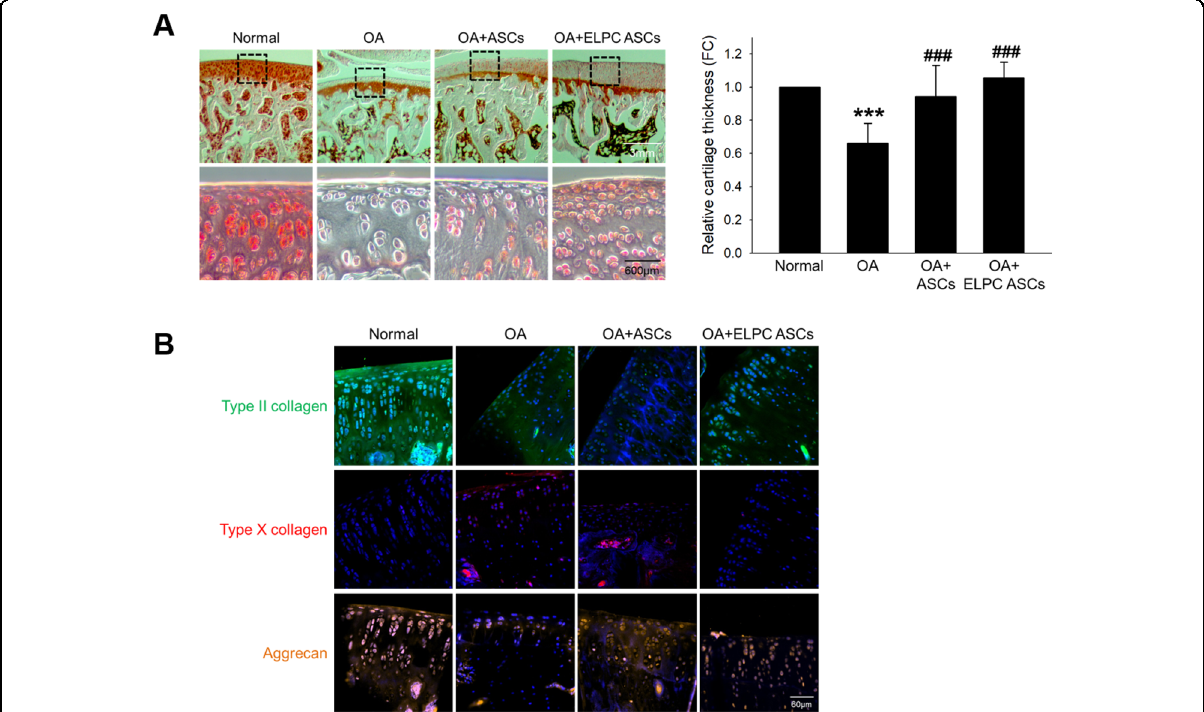
Fig. 6 ELPC-induced mechanism and protective effect in an animal model of OA. a Safranin O staining of the paraf fi n sections of the OA animal model. Representative images show cartilage damage after 6 weeks of OA induction. Safranin O binds to glycosaminoglycan in cartilage and is shown in red. The lower fi gure shows an enlargement of the cartilage part in the upper fi gure, scale bar: upper 3 mm and lower 600 μ m. Graph indicating the relative cartilage thickness. *** p < 0.001 compared to the normal control, ### p < 0.001 compared to the animal model of OA. n = 3. b Detection of mature and hypertrophic chondrocyte markers in the OA animal model. Type II collagen (FITC, green), aggrecan (Texas red, red), and type X collagen (rhodamine, orange) expression was measured by immuno fl uorescence staining and visualized with a confocal microscope. Each section was costained with DAPI (blue) for nuclear staining. The images in the same region of tissue were merged into the overlapped image. Scale bar: 60 μ